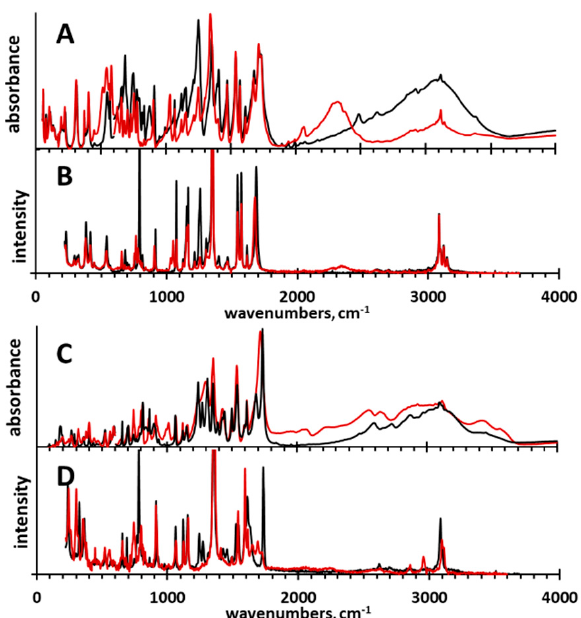
Figure 10. Normalized experimental IR and Raman spectra of 3 ( A and B ) and 4 ( C and D ) (black spectra) and their deuterated (OD) derivatives (red spectra).